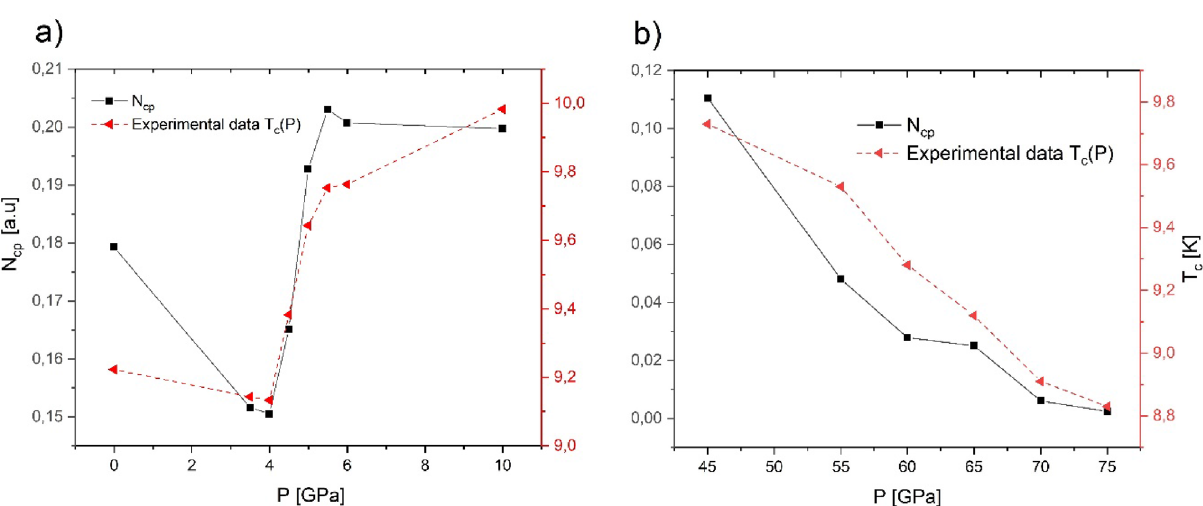
Figure 4. T c experimental data 3 and N cp as a function of pressure for Nb: ( a ) 0 ≤ P ≤ 10GPa and ( b ) 45 ≤ P ≤ 75GPa